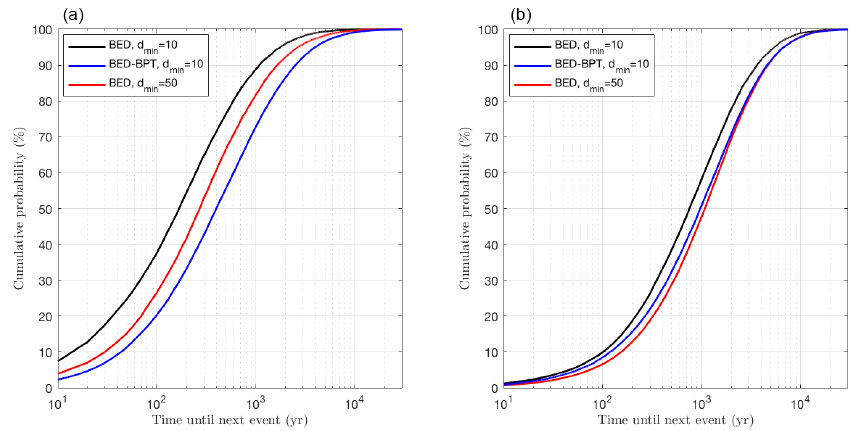
Figure 16. Posteriors of next earthquake time for Fiamignano (a) and Frattura (b) according to BED with d min = 10 and d min = 50, and according to a hybrid BED-BPT approach (with d min = 10 in the BED